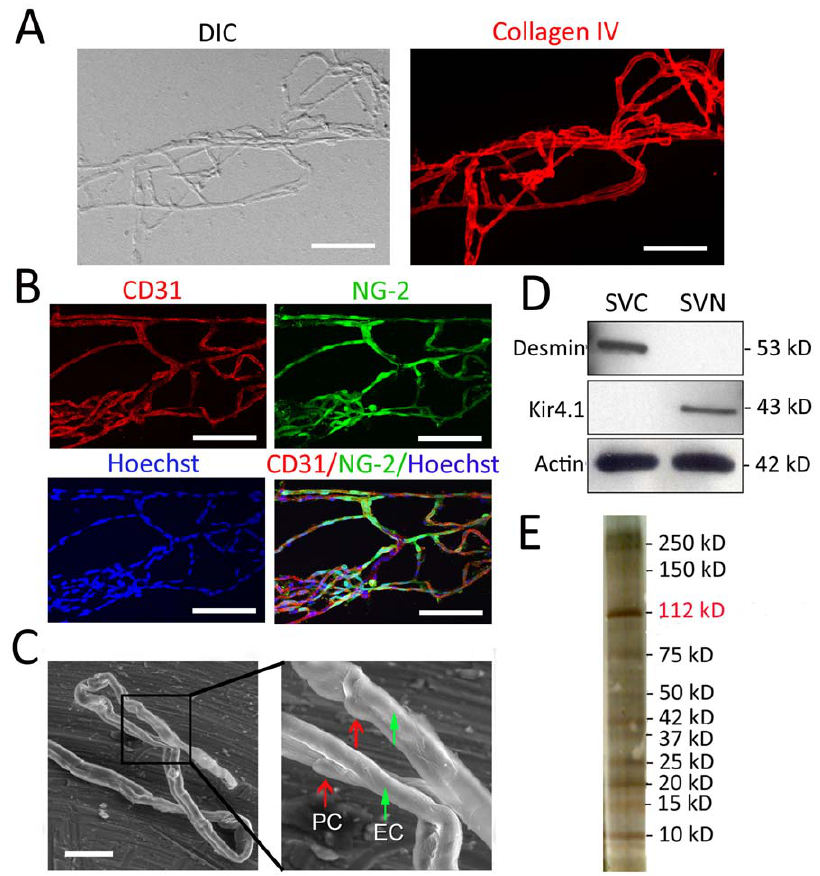
Figure 2. Characterization of isolated SV capillaries. A , A DIC image (Left) of an isolated mouse SV capillary network obtained by the ‘‘sandwich-dissociation’’ method (see Materials and Methods ). The capillary is immunolabeled with an antibody for collagen type IV to show the basement membrane (Right). B , Images of isolated capillaries triple labeled for EC marker protein CD31 (red channel), PC marker protein NG-2 (green channel), and Hoechst for nuclei (blue channel) verify absence of non-vascular cell contamination in the capillary preparation. C , A scanning electron micrograph of isolated capillaries (Left), with the accompanying higher magnification image, shows PCs on the isolated capillaries (Right, arrows). D , Immunoblot analysis of the isolated capillaries. The pericyte marker protein desmin is detected only in the capillary fraction, while the intermediate cell marker protein Kir 4.1 is only detected in the non-vascular fraction, confirming the preparation is uncontaminated by intermediate cells. SVC, stria vascularis capillary fraction; SVN, stria vascularis non-vascular fraction. E , One-dimensional SDS-PAGE separation of the isolated capillary proteins, silver stained. Migration positions corresponding to the NKA a 1 subunit (112 kD) and its major bands are indicated (Scale bars: A and B , 100 m m; C , 50 m m) Data in all panels are representative of at least 3 separate experiments.